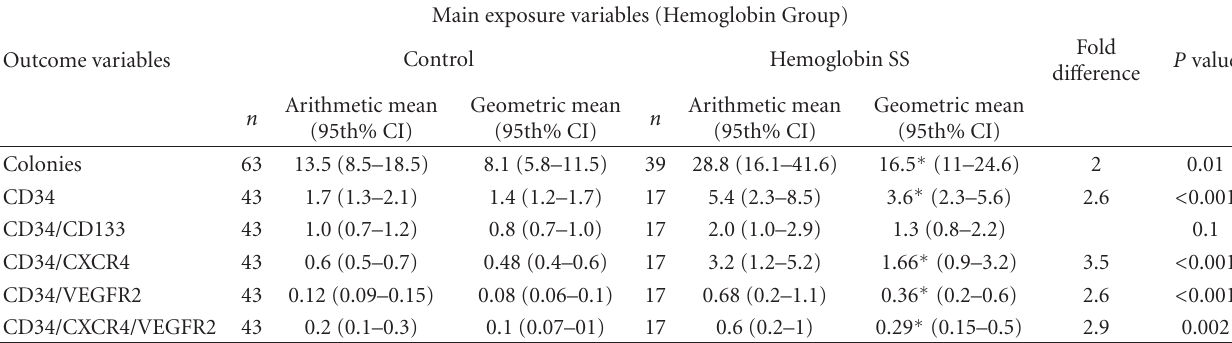
Table 2: Number of mononuclear cell colonies and CPCs for each Hemoglobin Group. Children with Hemoglobin SS had